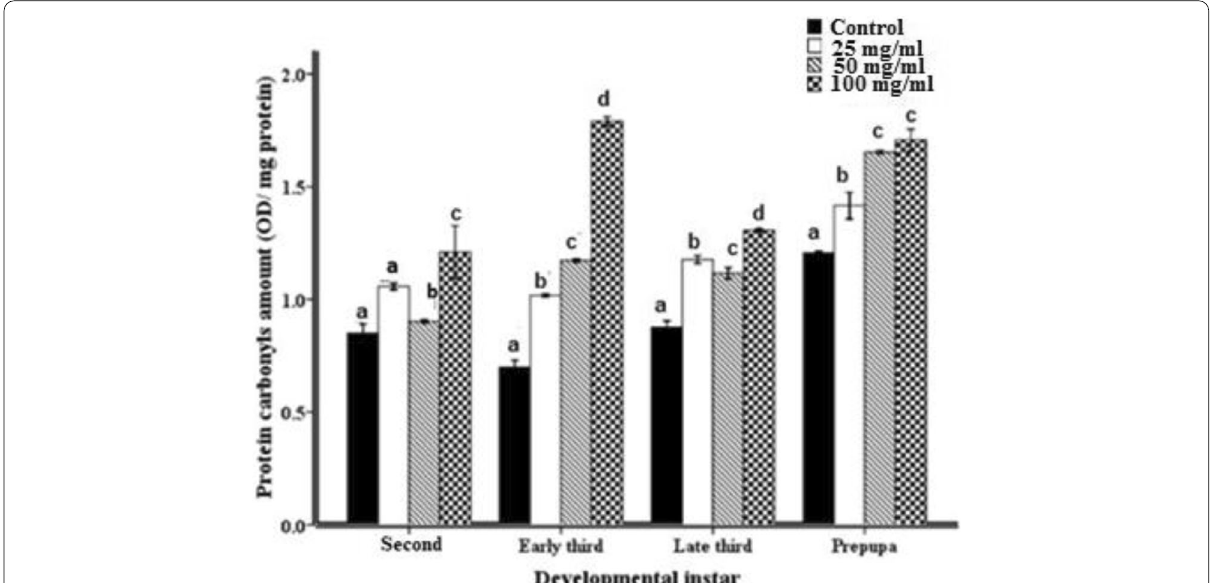
Fig. 3 Detection of protein carbonyle amount (OD/mg protein) in larval and prepupal tissues of Sarcophaga argyrostoma , which fed on different concentrations of clonazepam (25, 50, or 100 mg/ml). Data expressed as median and standard deviation (SD). Median values marked with different small letters were significantly different ( p < 0.05) regarding to clonazepam concentration